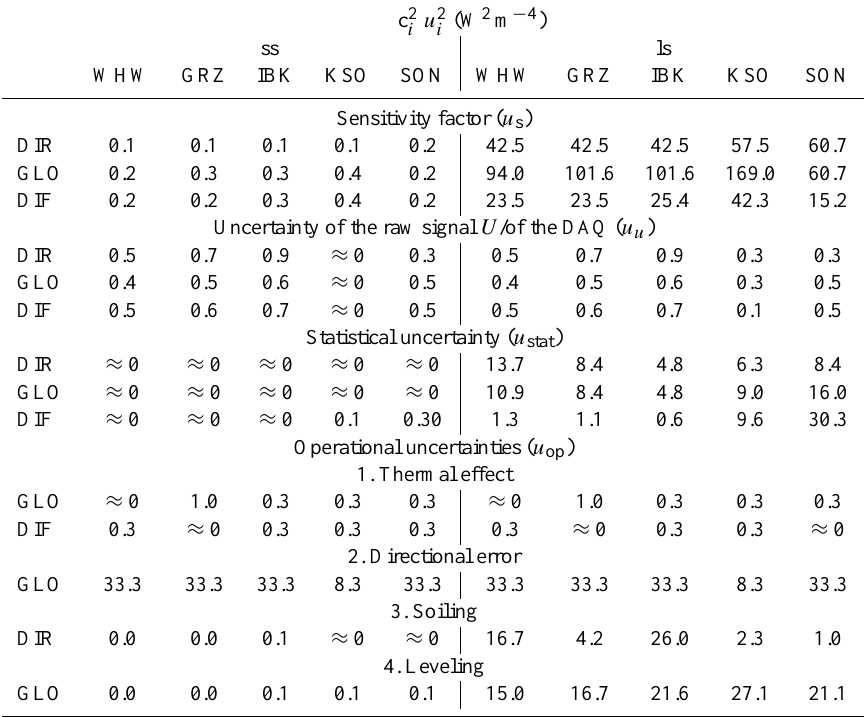
Table 6. Same as Tables 4 and 5 but products of sensitivity factor c i and standard uncertainty u i . Numbers are given for a small (ss: 50Wm − 2 ) and a large (ls: 500Wm − 2 for DIF and 1000Wm − 2 for DIR and GLO)